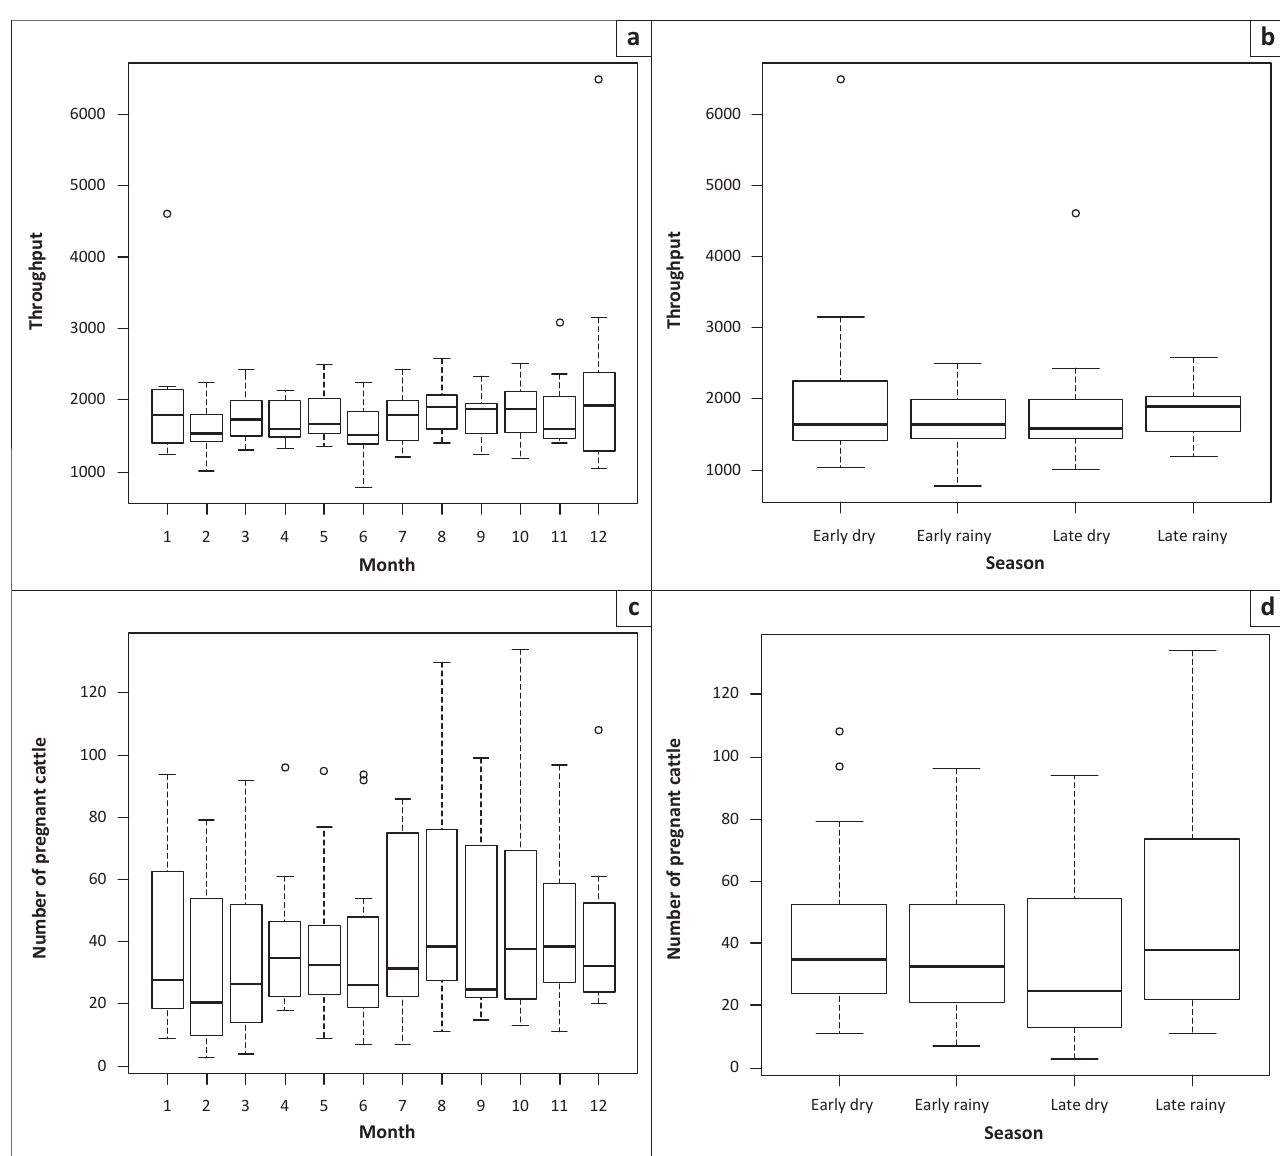
FIGURE 1-A2: Monthly and seasonal rate of throughput, slaughter of pregnant animals and foetal wastage for cattle, Minna Metropolitan Abattoir, Nigeria, during 2001–2012. (a) Monthly throughput for cattle, (b) seasonal throughput for cattle, (c) monthly slaughter of pregnant cattle, (d) seasonal slaughter of pregnant cattle, (e) monthly rate of foetal wastages in cattle and (f) seasonal rate of foetal wastages in